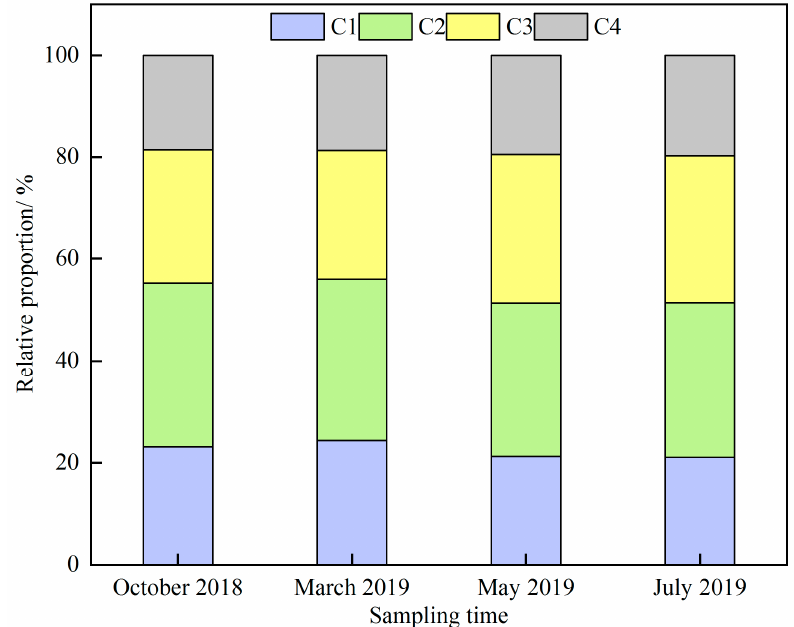
Figure 6. Relative proportion of the fluorescence components of DOM in the overlying water of Lake Hulun.